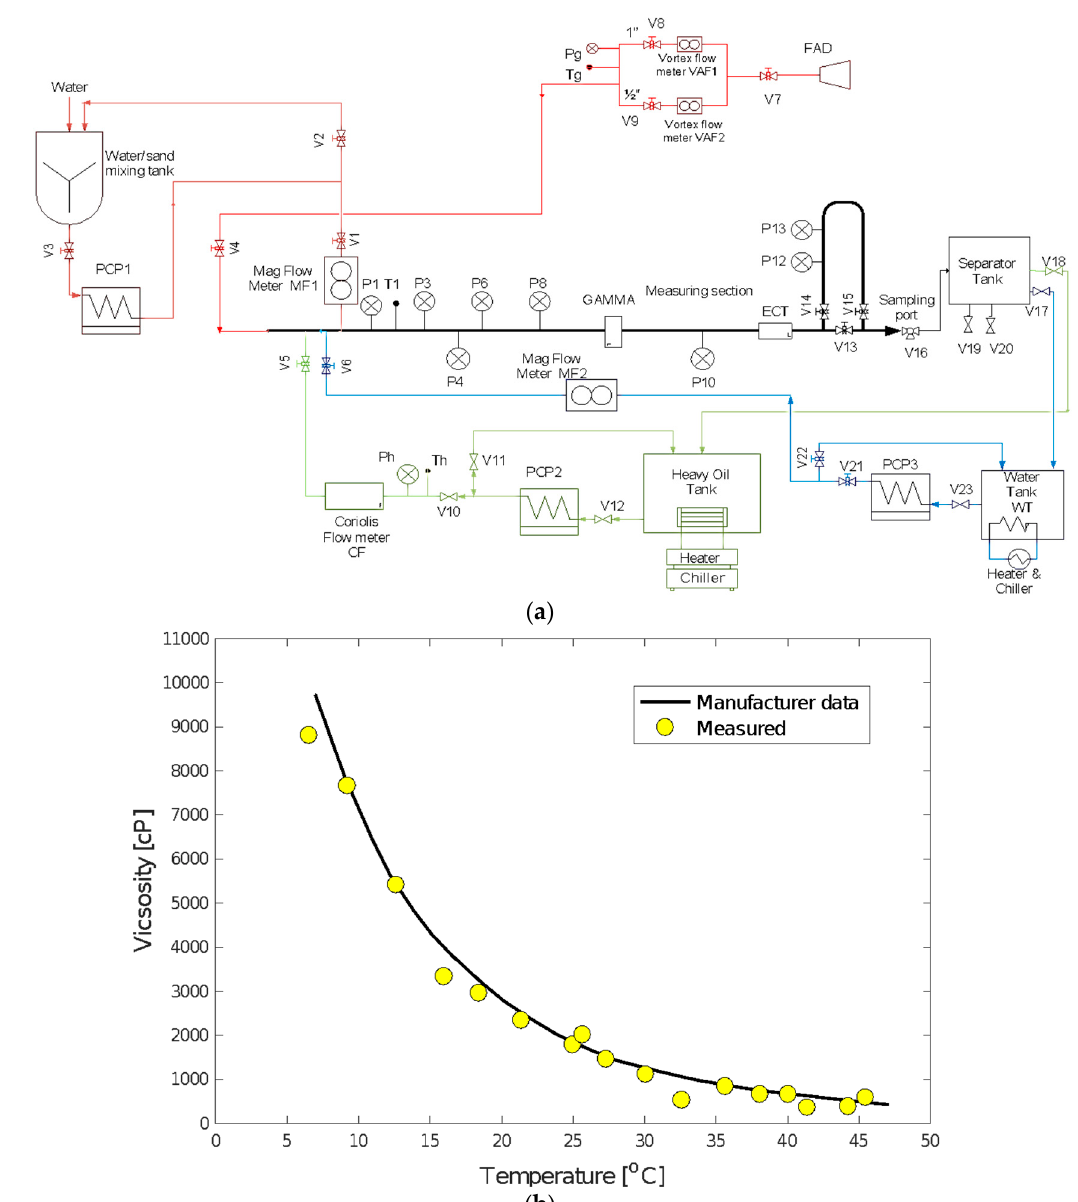
Figure 2. Experimental test facility ( a ) Schematic ( b ) A comparison of measured with manufacturer-supplied temperature response of viscosity.